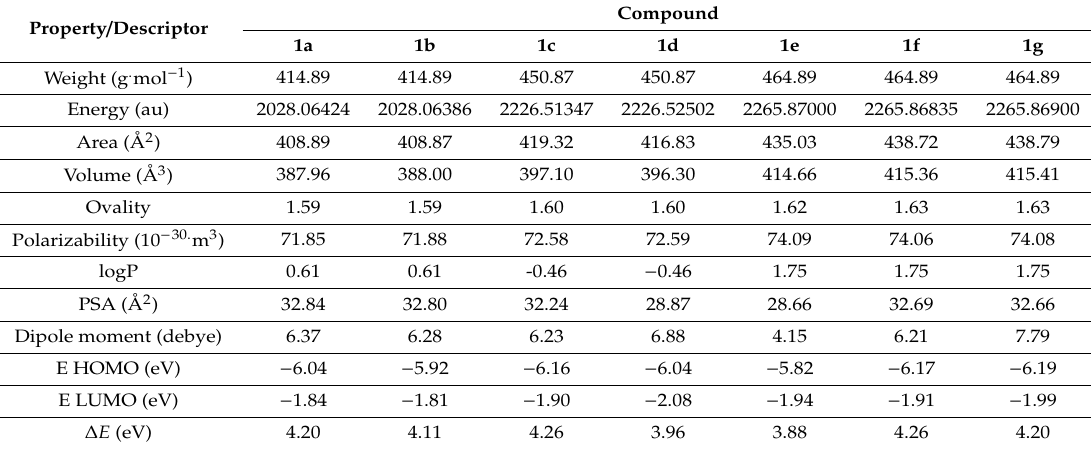
Table 1. Molecular properties and descriptors for 1a – g compounds, calculated with Spartan’18 software. Property / Descriptor